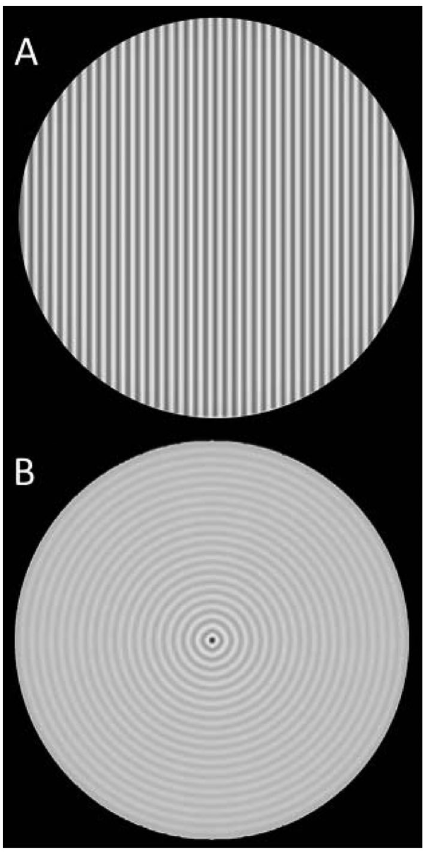
Figure 1. Examples of vertical linear ( A ) and circular concentric ( B ) grating stimuli